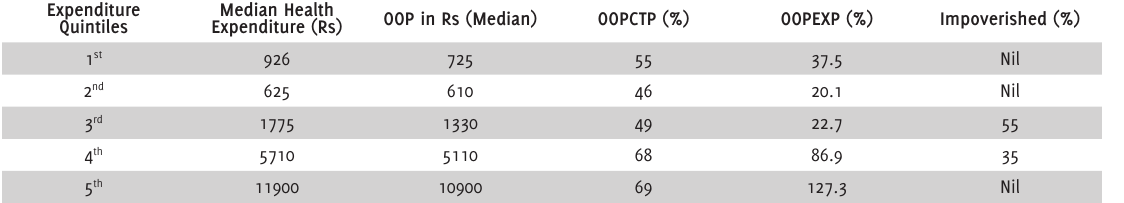
Table 4. Health Expenses Incurred across the Expenditure Quintile (n = 100) Expenditure Quintiles